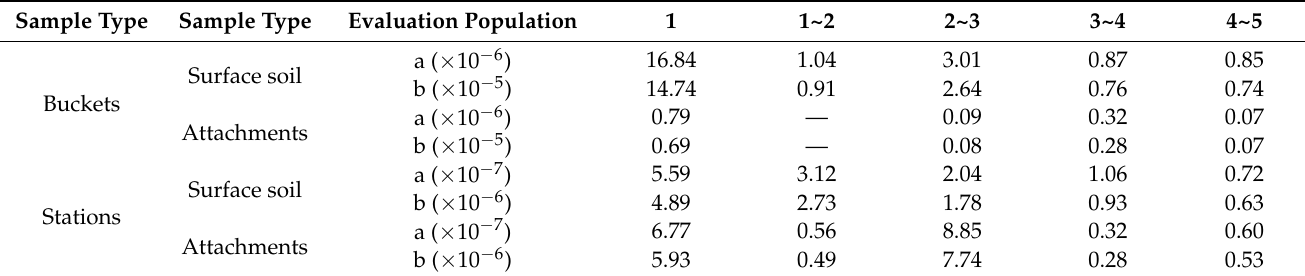
Table 9. Annual non-carcinogenic risks of soil mercury for adults and